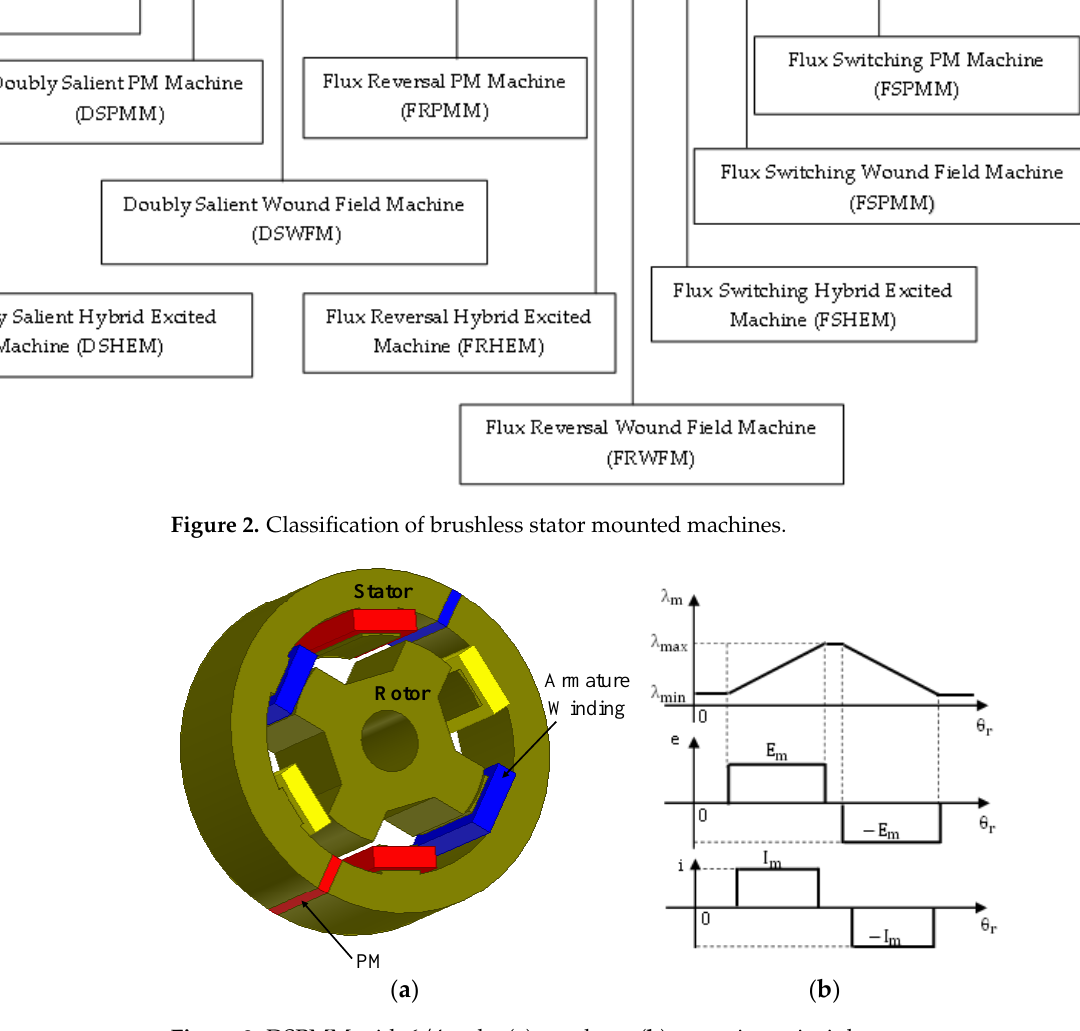
Figure 3. DSPMM with 6/4-pole: ( a ) topology; ( b ) operating principle. Torque Ripple Operating Principles